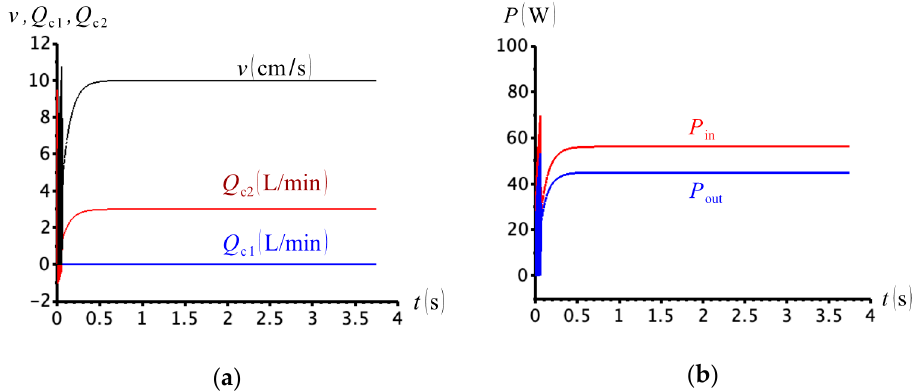
Figure 33. ( a ) Cylinder velocity and compensation flows; ( b ) input and output powers ( m = 0.5 kg ).